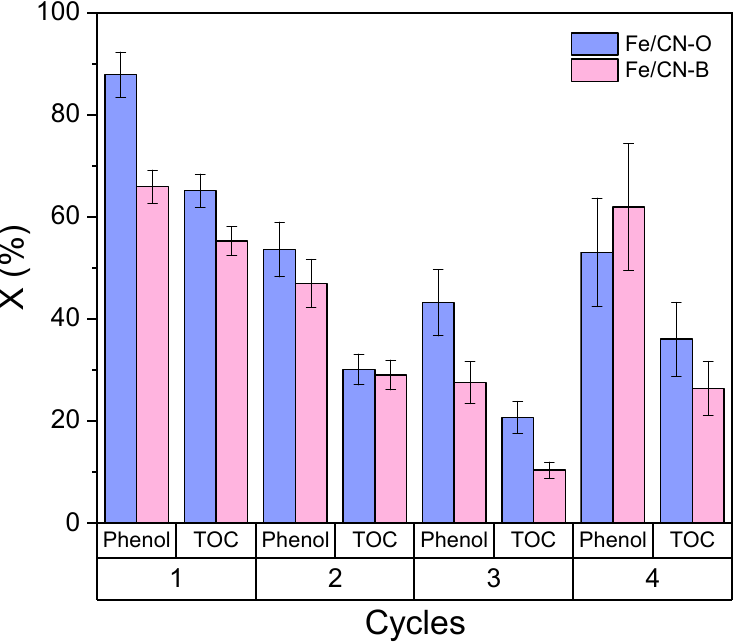
Figure 6. Evolution of TOC and phenol conversion along for reused cycles for Fe/CN-B and Fe/CN-O catalysts. Reaction conditions: 50 mL initial reaction volume, 100 mg·L − 1 phenol in ultrapure water, 500 mg·L − 1 catalyst, 500 mg·L − 1 H 2 O 2 , pH 3, 200 rpm, 50°C, 120 min reaction time.